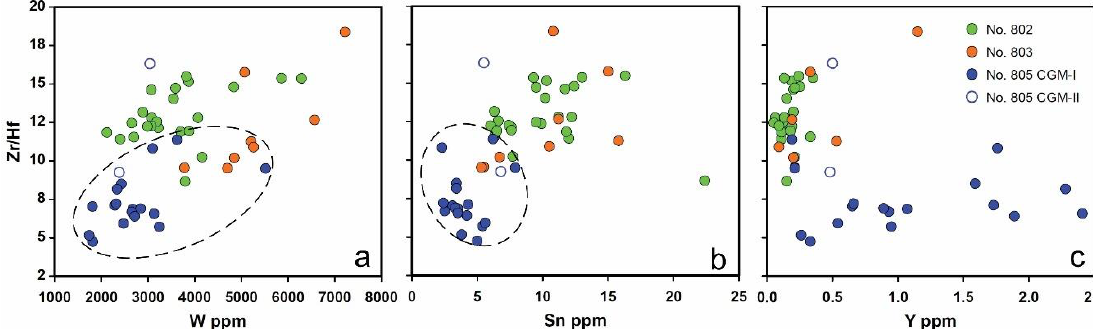
Figure 10. Correlations between Zr / Hf ratios and W, Sn, and Y concentrations of the CGMs from the Li-rich pegmatites at Kalu’an. ( a ) Zr / Hf ratio versus W, ( b ) Zr / Hf ratio versus Sn, and ( c ) Zr / Hf ratio versus Y.